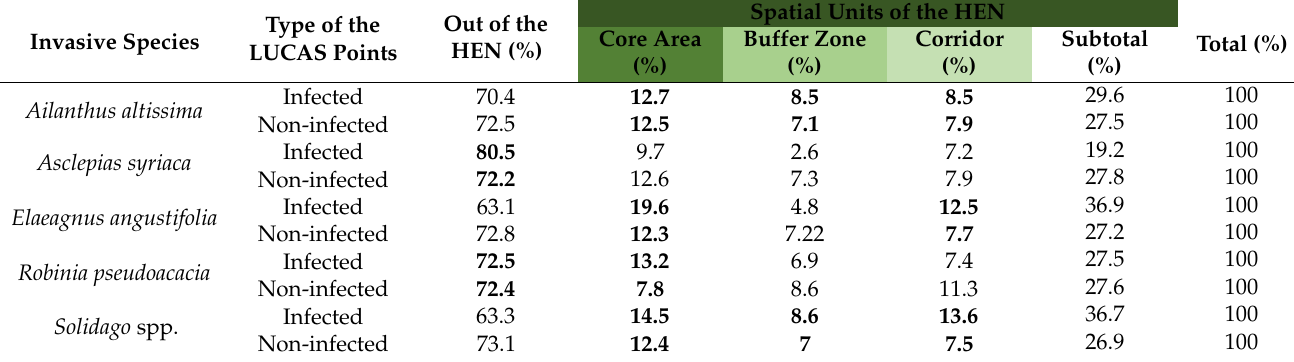
Table 2. The spatial distributions of LUCAS points infected and non-infected by the invasive plants, inside and outside the spatial units of the HEN (The bold numbers show those proportion data-pairs, where the proportion of a given invasion plant infected points is higher (overrepresented), than the proportion of non-infected LUCAS points within the given territorial